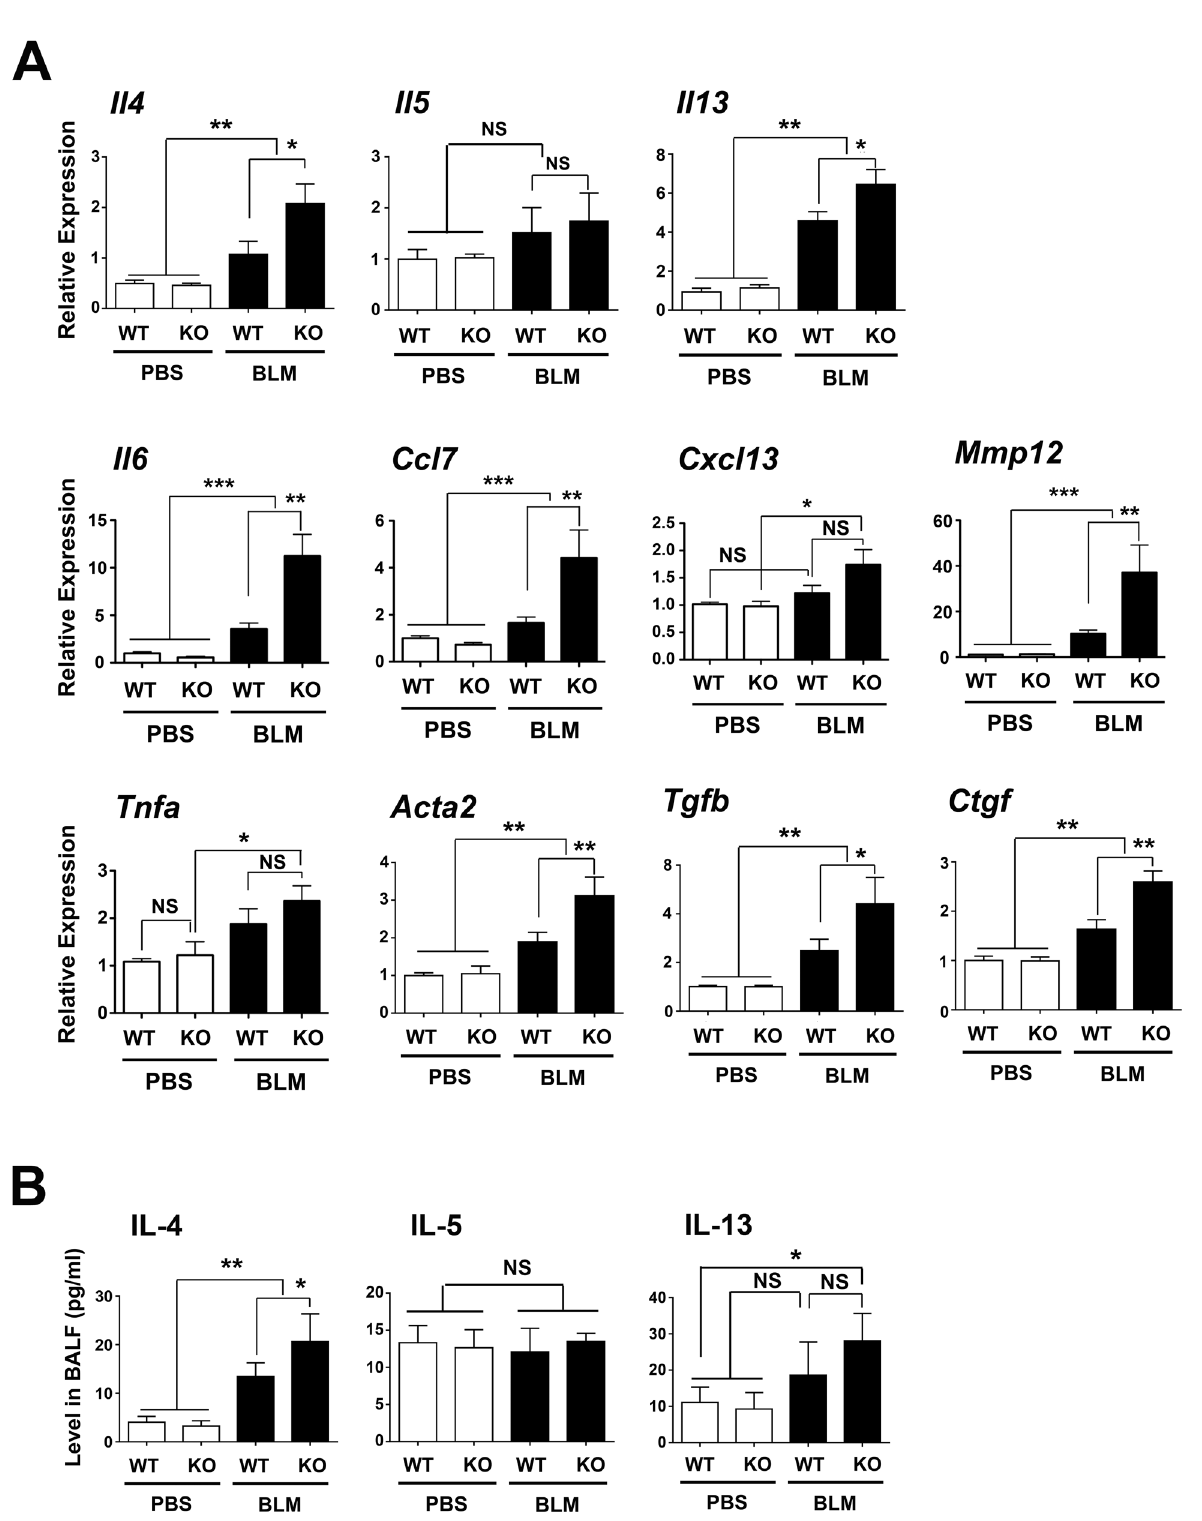
Fig 4. Increased cytokine levels in BLM-treated Scgb3a2 -null lungs. (A) qRT-PCR analysis of mRNAs encoding IL-4, IL-5, IL-13, IL-6, CCL7, CXCL13, MMP12, TNF α , ACTA2 ( α -smooth muscle actin), TGF β , and CTGF in lungs of wild-type (WT) and Scgb3a2 -null (KO) mice intubated with BLM or PBS as control. Normalization control used was 18S. (B) IL-4, IL-5, and IL-13 protein levels in BALF of wild-type (WT) and Scgb3a2 -null (KO) mice intubated with